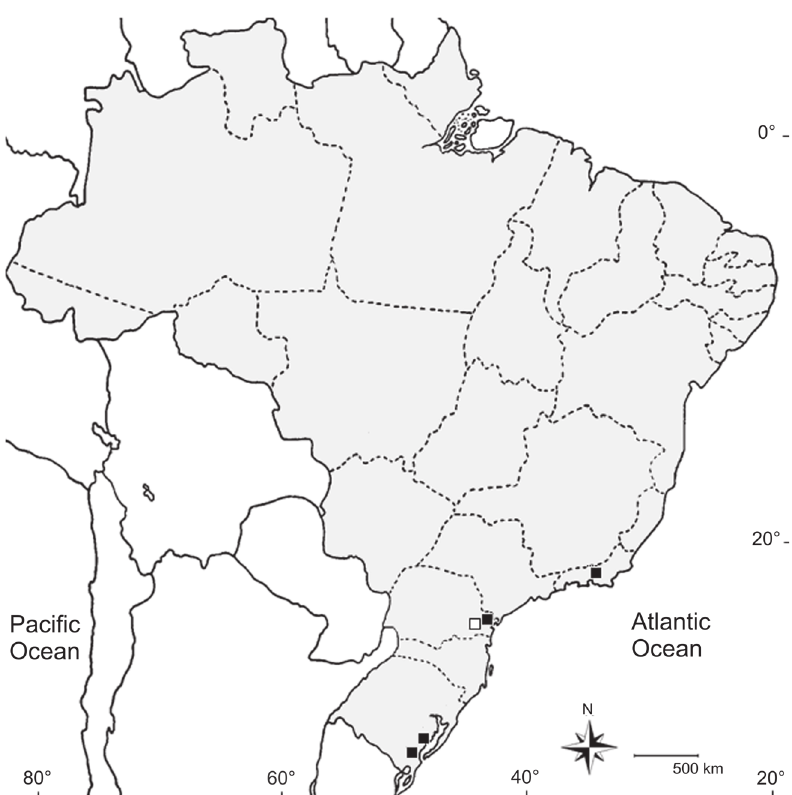
Figure 18. Map showing the distribution of Psilocymbium antonina sp. nov. ( (cid:133) ) and P. lineatum ( (cid:132) ) in